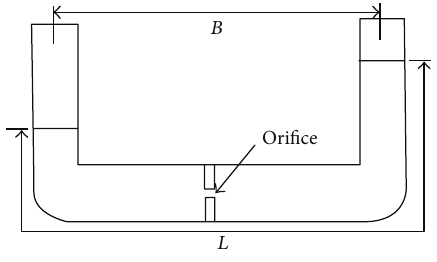
Figure 8: The tuned liquid column damper.